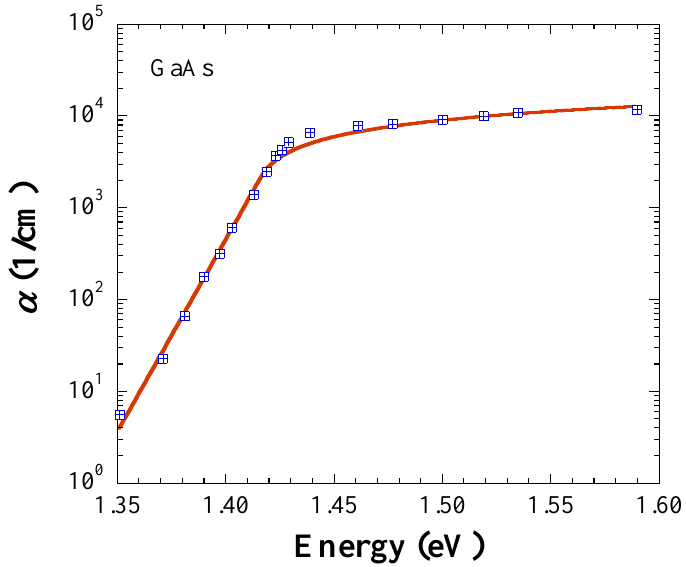
Figure 4. Absorption coefficient of GaAs. The symbols are retrieved from Ref. [10], and the solid line represents the fit with Equations (5) and (6). Table 1. Fit parameter for the fits in Figures 1 – 4.